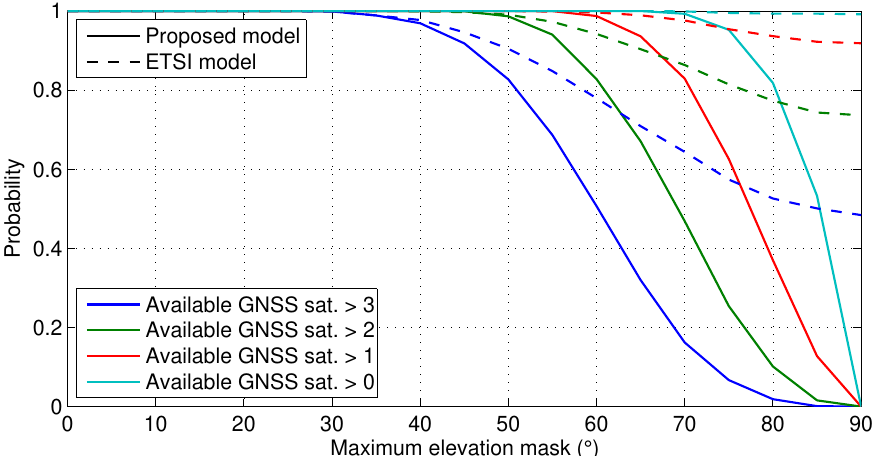
Figure 3. Probability of a minimum number of visible GNSS satellites per maximum elevation mask for the ETSI TS 103.246-3 [13] and the proposed models.